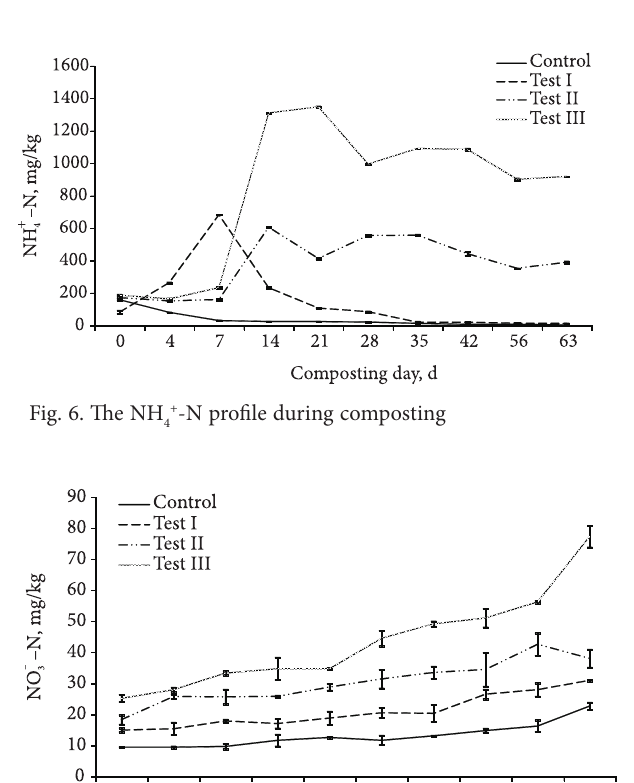
Fig. 5. The C/N ratio profile during composting